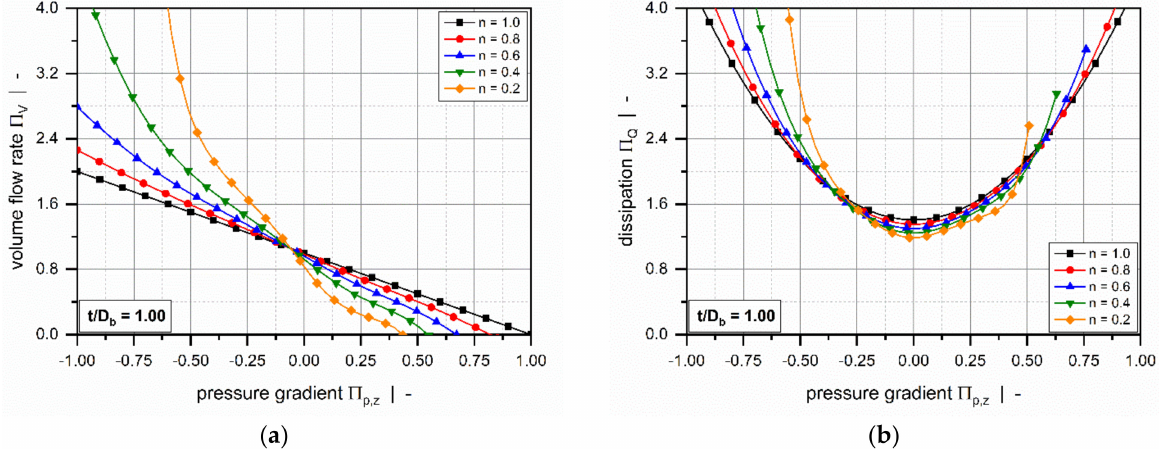
Figure 8. Influence of the power-law index on a fully developed two-dimensional flow of a power-law fluid in a screw channel of infinite width under isothermal conditions. The dimensionless volume flow rate Π V as a function of the dimensionless pressure gradient Π p , z ( a ), and the dimensionless dissipation Π Q as a function of the dimensionless pressure gradient Π p , z ( b ).